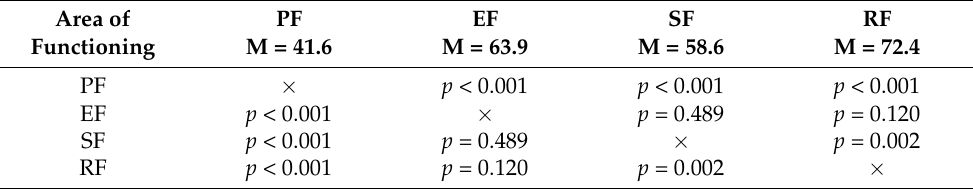
Table 3. Results of multiple comparisons between scores for the investigated areas of the children’s functioning.